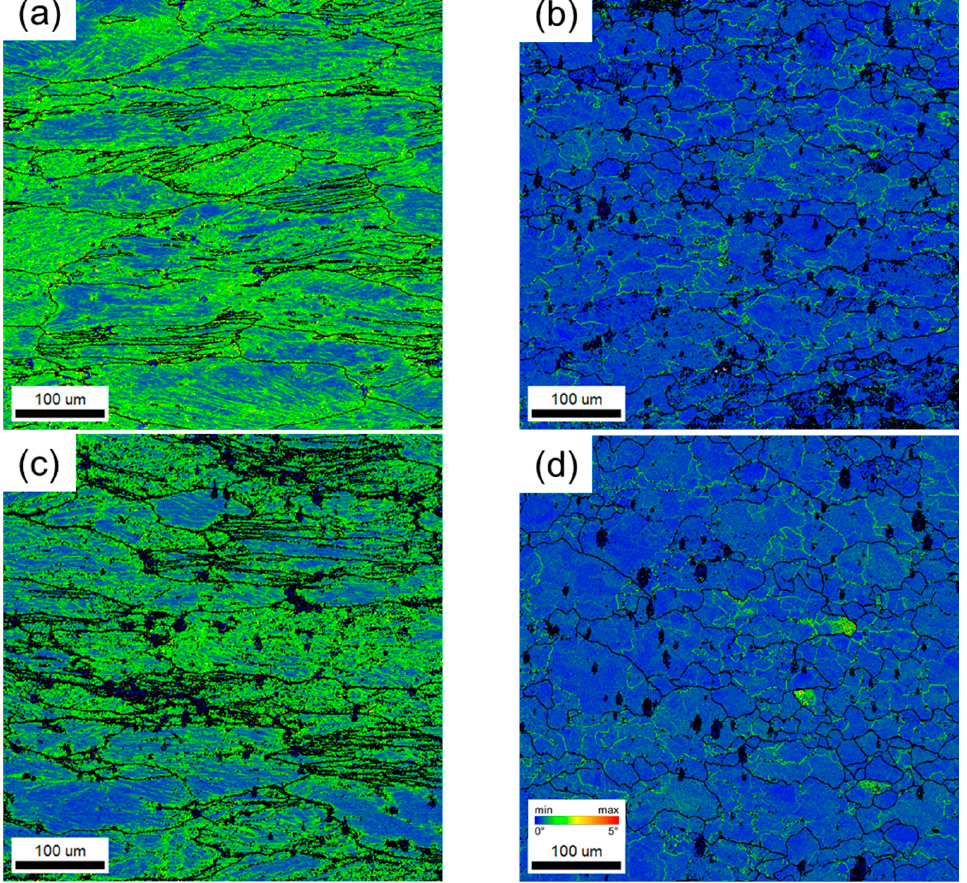
Figure 5. KAM maps of the ( a ) Al-6Mg, 300 ° C , 10 0 /s, ( b ) Al-6Mg, 400 ° C , 10 − 3 /s, ( c ) Al-8Mg, 300 ° C , 10 0 /s, ( d ) Al-8Mg, 400 ° C , 10 − 3 /s.